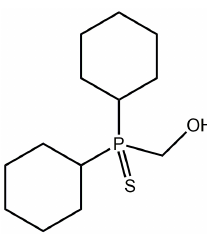
Figure 1. Chemical diagram for [dicyclohexyl(sulfanylidene)- λ 5 -phosphanyl]-methanol (Compound 1 ).